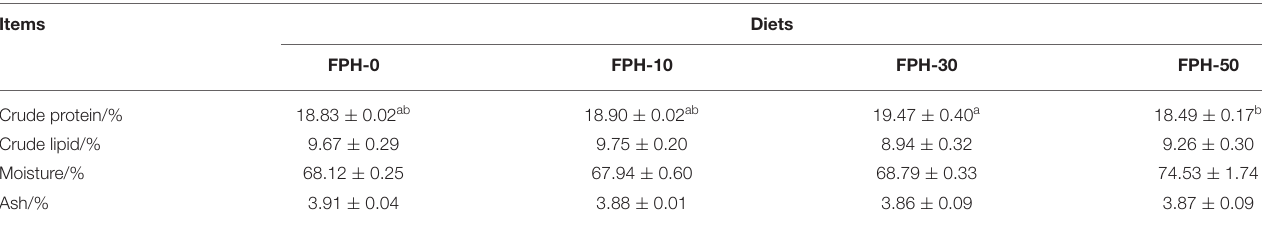
TABLE 6 | The whole-body compositions of largemouth bass ( Micropterus salmoide s) fed the diets containing different supplementation levels of fish protein hydrolysate